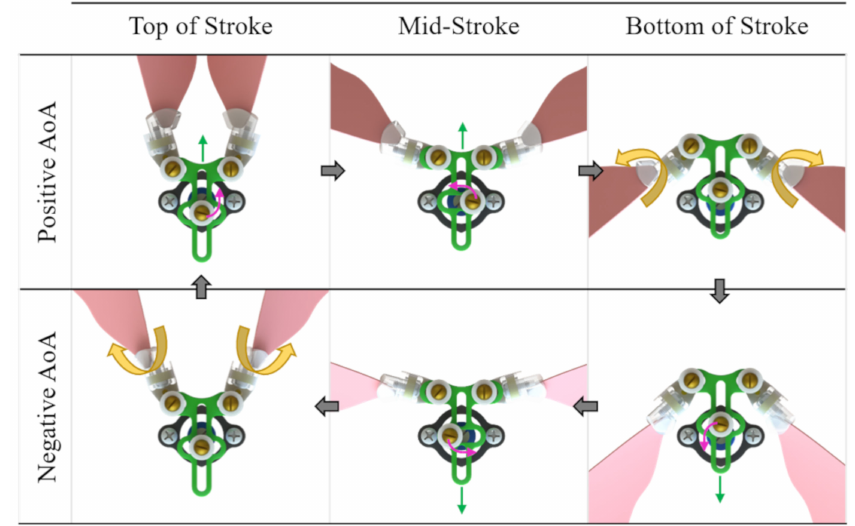
Figure 3. Complete flapping cycle of FWM 2.1 as viewed from the top. Starting from the top left corner of the diagram, the wings begin at the top of their stroke with positive angle of attack (AoA). As we proceed to the top middle picture, the crank (blue) rotates in the counter-clockwise direction, thus driving the yoke (green) upward and the wings (pink) downward. Subsequently, the crank rotates another quarter of a turn and the wings reach the bottom of their stroke. At this point, the wings passively flip from a positive to a negative angle of attack (note that this does not occur instantaneously like depicted in the diagram but over a brief amount of time and after the crank has rotated some small amount). The crank continues to rotate, driving the yoke downward and the wings upward. Lastly, with the wings at the top of the stroke, aerodynamic and inertial forces cause them to flip (passively rotate along the spanwise axis) into a positive angle of attack. Like the previous wing flip, this motion also does not occur instantaneously but over a short amount of time and after the crank has rotated a small